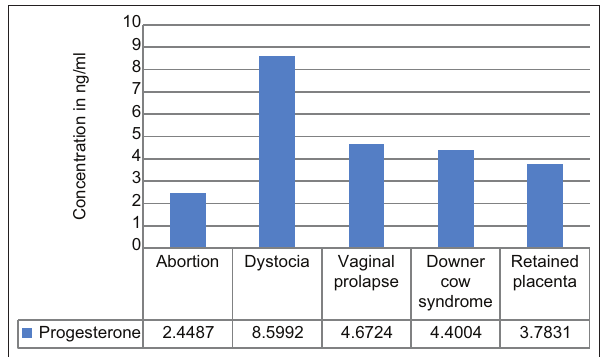
Figure-2: Concentration of progesterone serum in cows with different reproductive conditions. Table-4: Mean±standard error of progesterone in different reproductive conditions. Reproductive